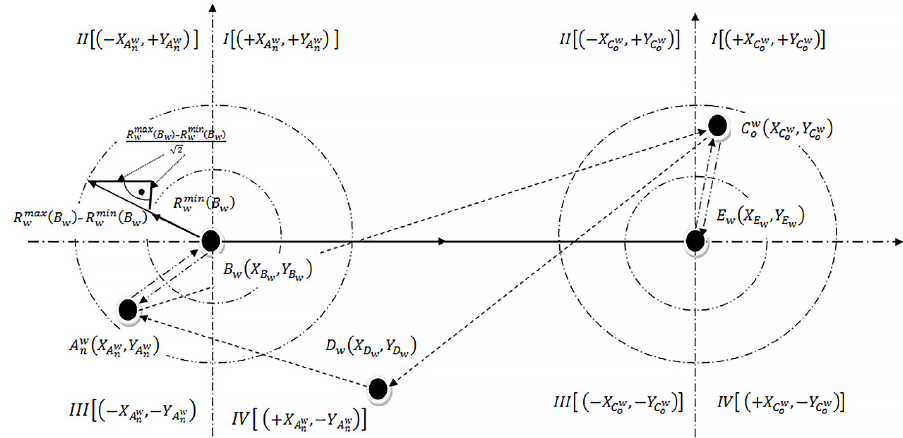
Figure 3. The distribution of consignors and consignees – graphic